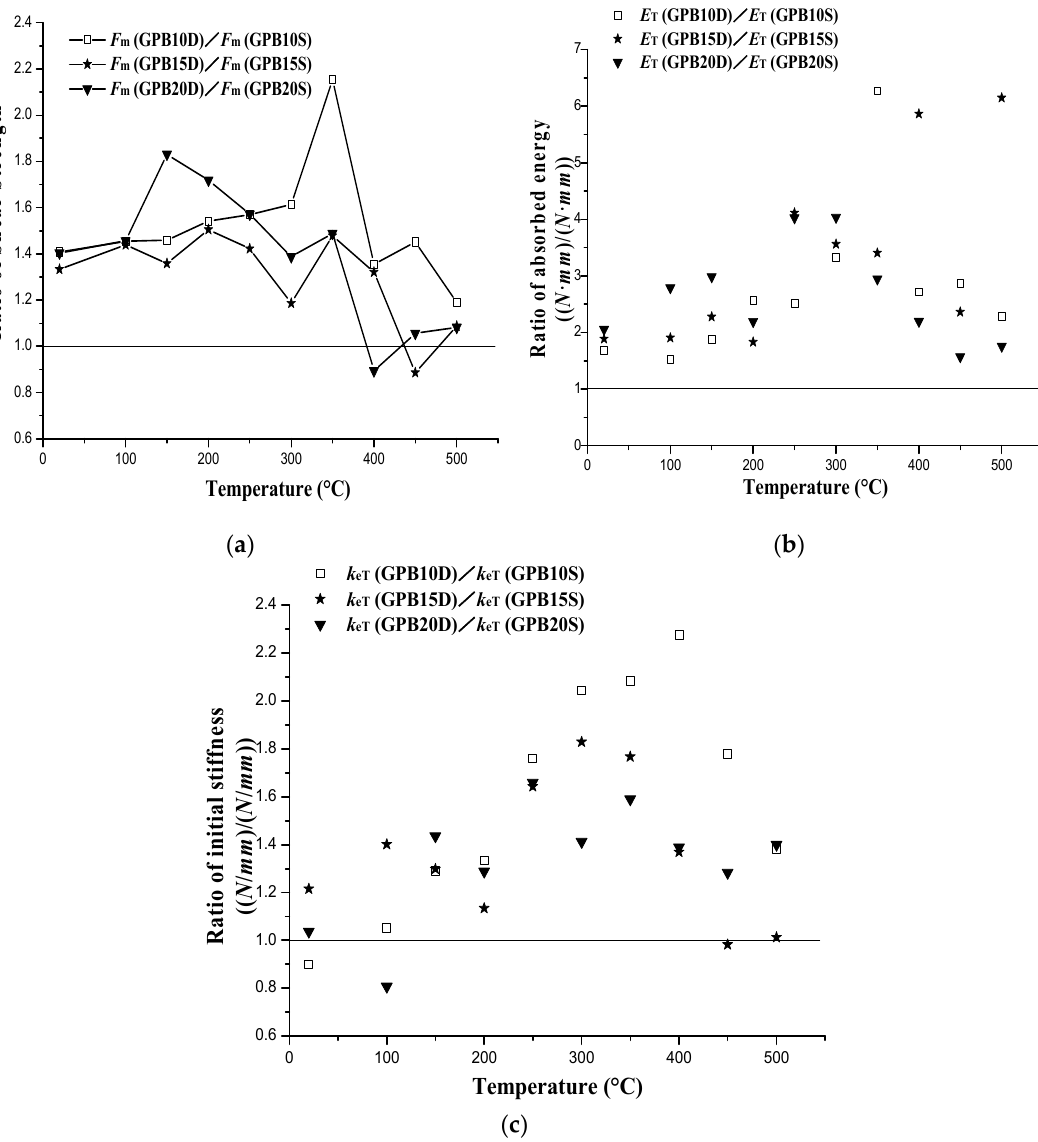
Figure 12. Effect of double-layer gypsum sheathing: ( a ) ratio of shear strength; ( b ) ratio of absorbed energy; and ( c ) ratio of initial stiffness.